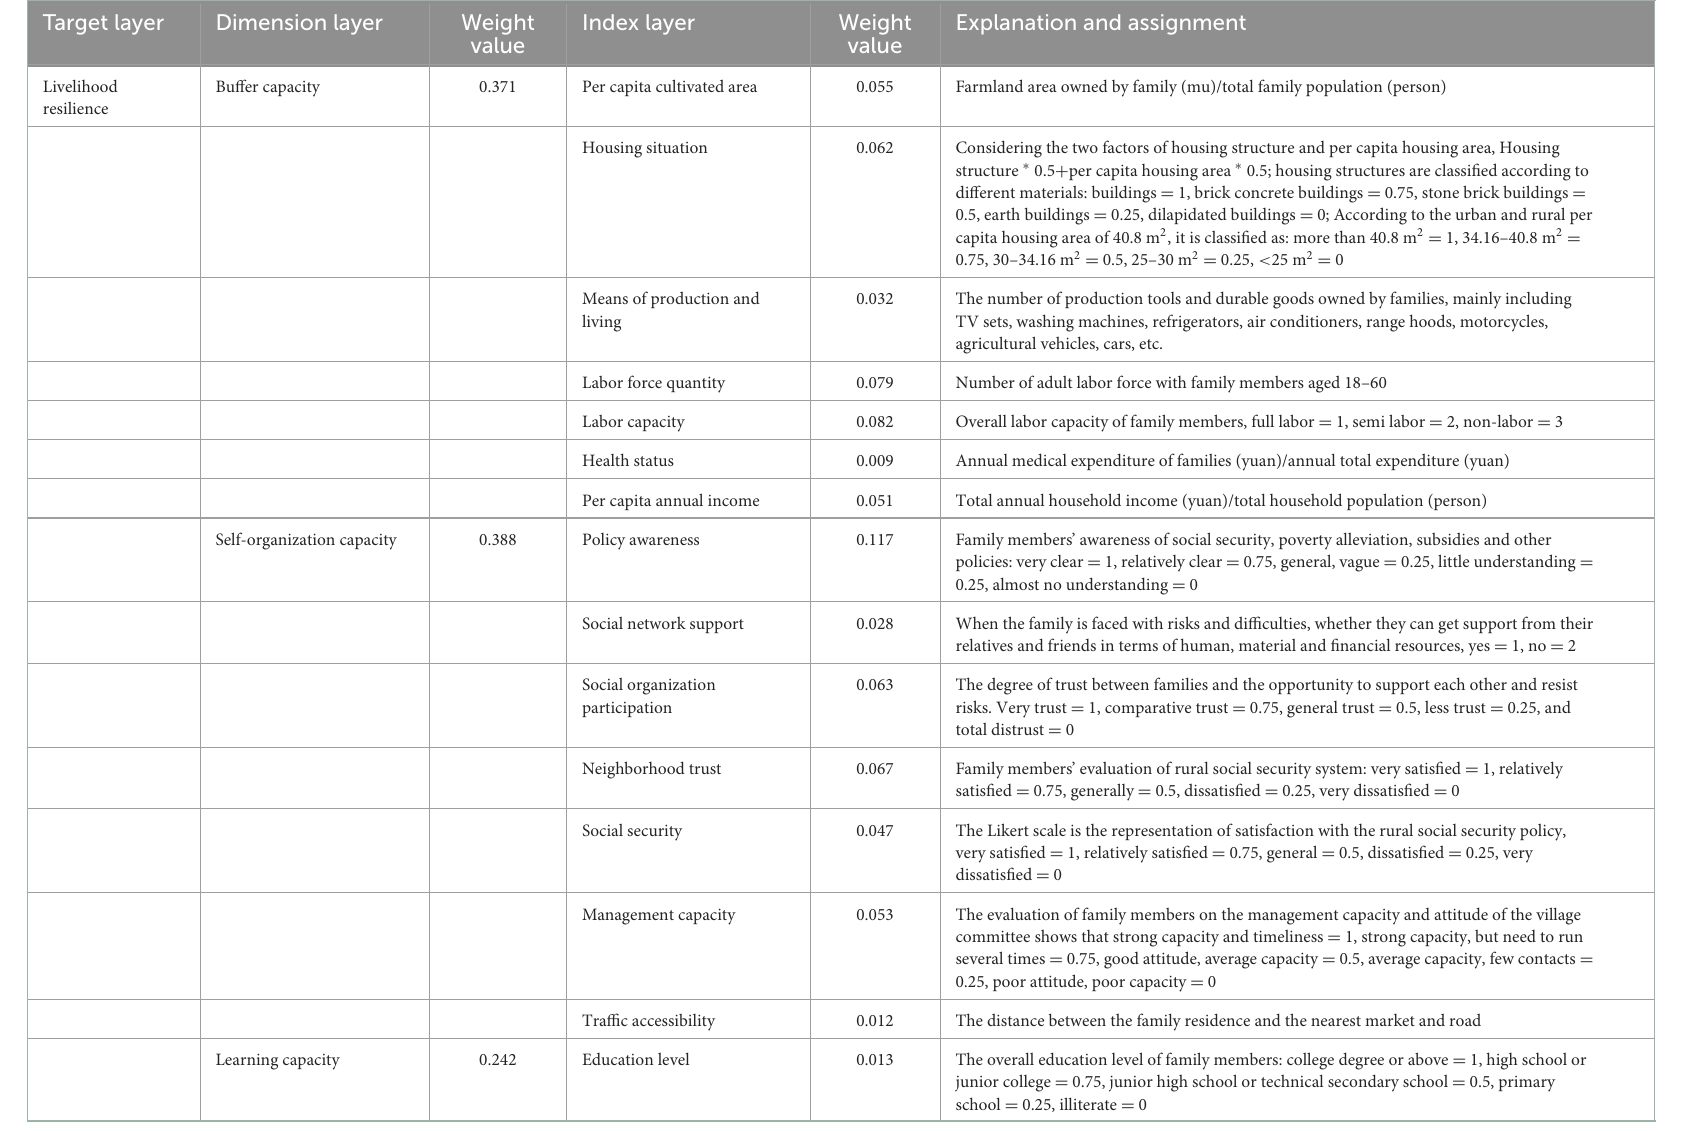
TABLE 3 Evaluation index system for livelihood resilience of resettled